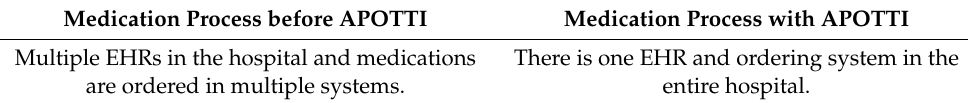
Table 1. Key changes in the medication management process before and after implementing a new electronic health record (EHR) system